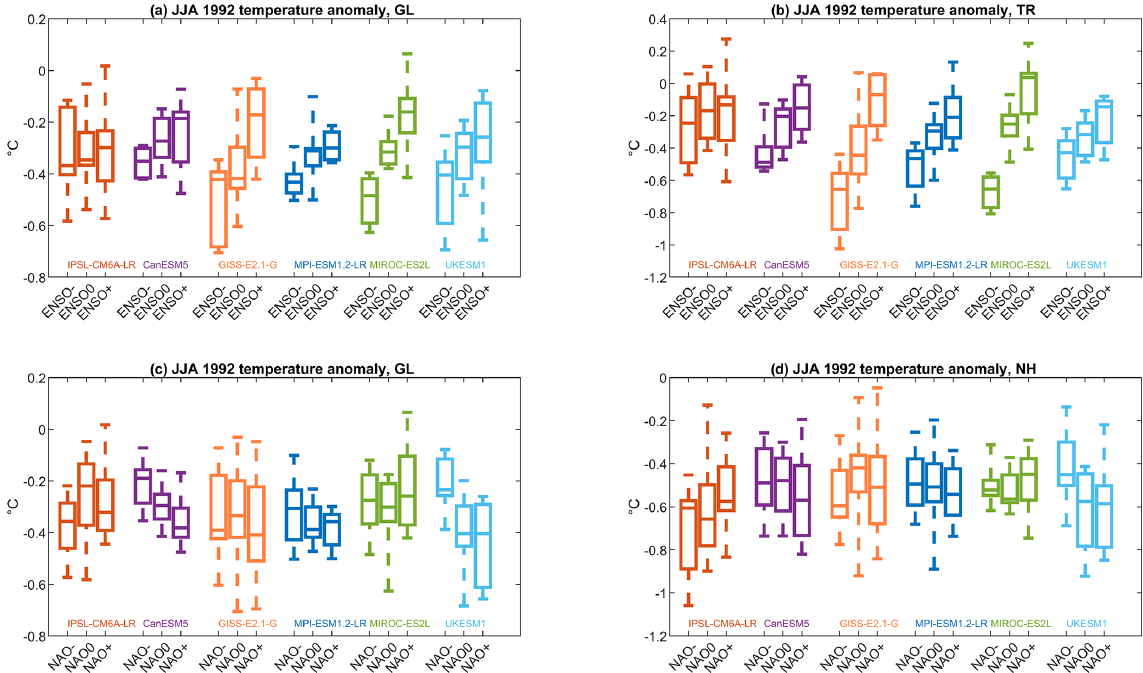
Figure 11. Box–whisker plots of near-surface air temperature anomalies of selected areas for the second post-eruption boreal summer (JJA 1992) in the volc-pinatubo-full multi-model ensemble against the sampling conditions identified by the VolMIP protocol. Sampling conditions are identified by standardized winter-average (DJF) Niño3.4 and NAO states (positive if > 0 . 5, negative if < − 0 . 5, neutral/zero if in between) during the first post-eruption winter under unperturbed conditions (see Sect. 2.2). These states are accordingly used to cluster the temperature